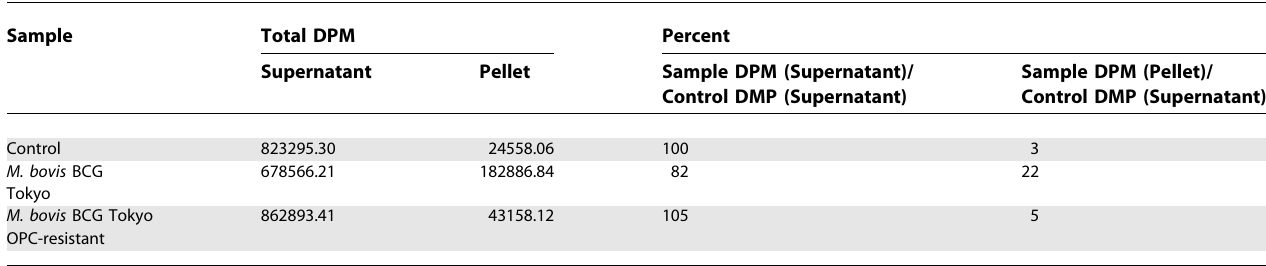
Table 6. Analysis of OPC-67683-Susceptible and -Resistant M. bovis BCG Using Radio-Labelled OPC-67683 Sample